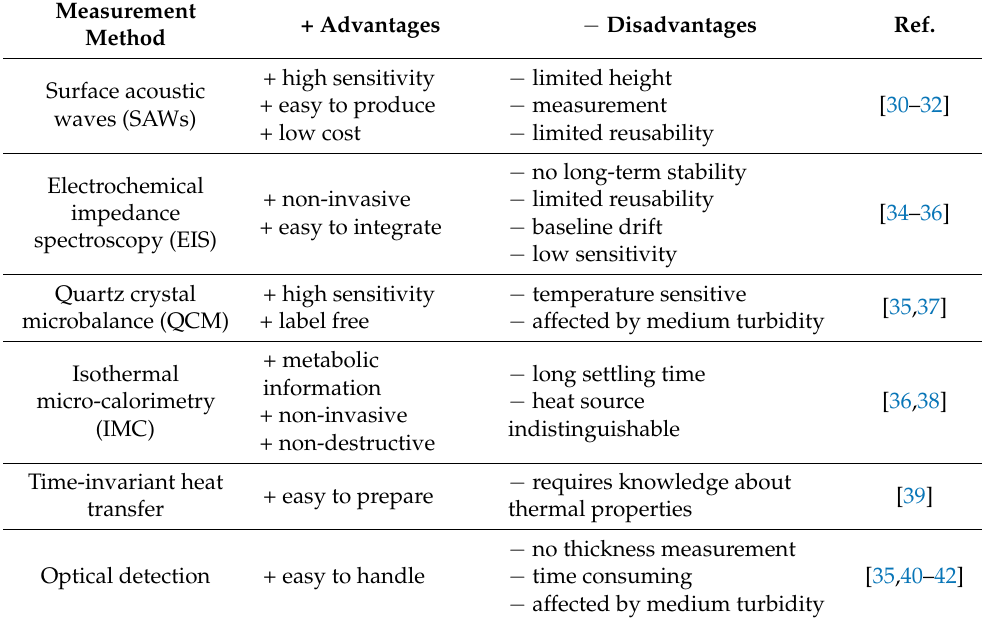
Table 1. State of the art bacterial adherence monitoring. Summary with advantages and disadvan- tages of the measurement